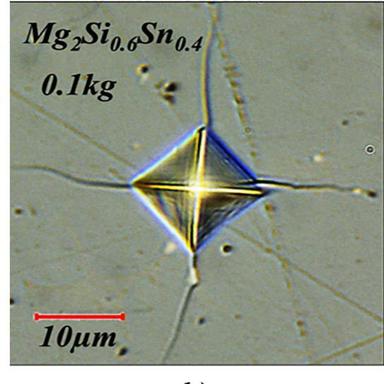
Vickers microhardness indentations of a) MnSi1.77 and b) Mg2Si0.6Sn0.4.